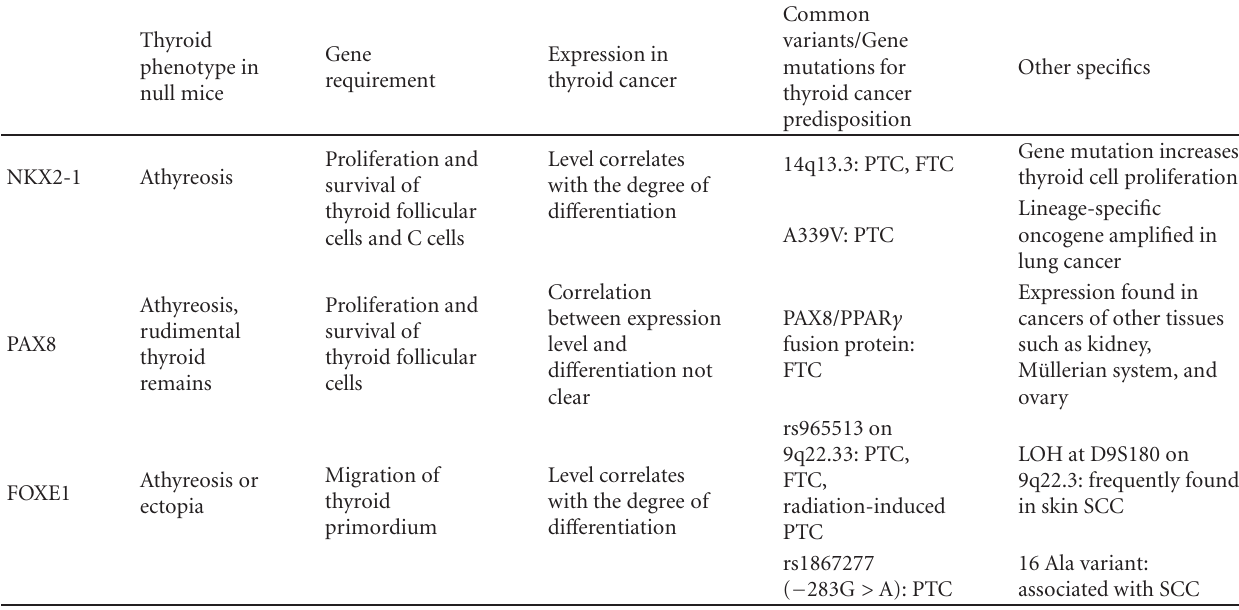
Table 1: Thyroid-specific transcription factors and thyroid